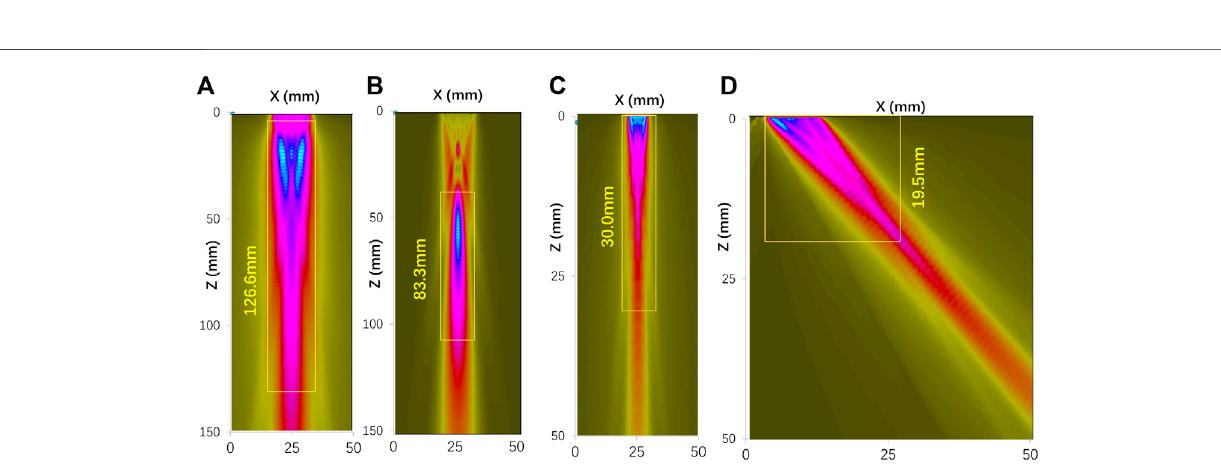
Figure 3 . Other frequencies such as 3, 4, and 6 MHz are also simulated. The sound fi eld distribution simulation in the leaf zone of E4 or E5 in the split pin was shown in Figure 4 . taking the leaf zone for example. The calculation results show that 5 MHz is a suitable frequency.